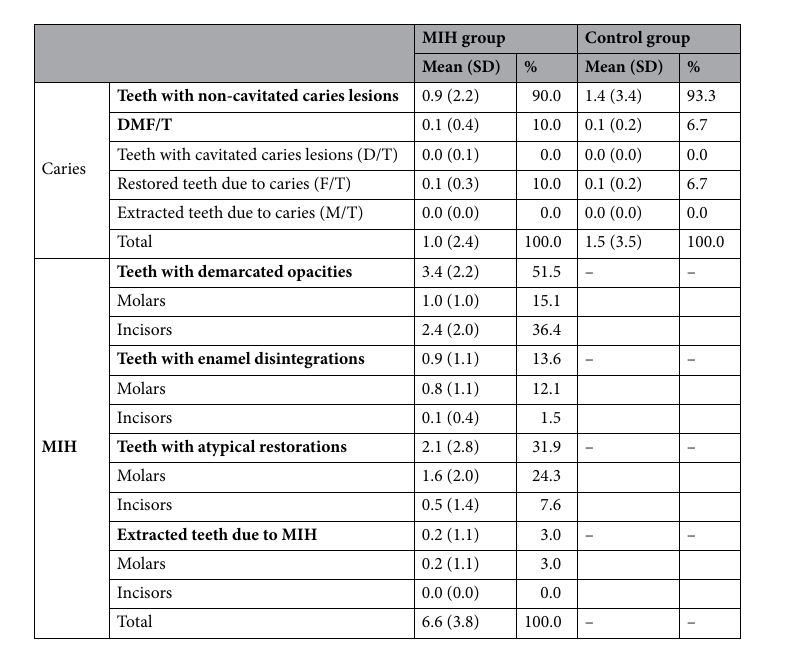
Table 2. Characterization of the dental status in the permanent dentition of both study